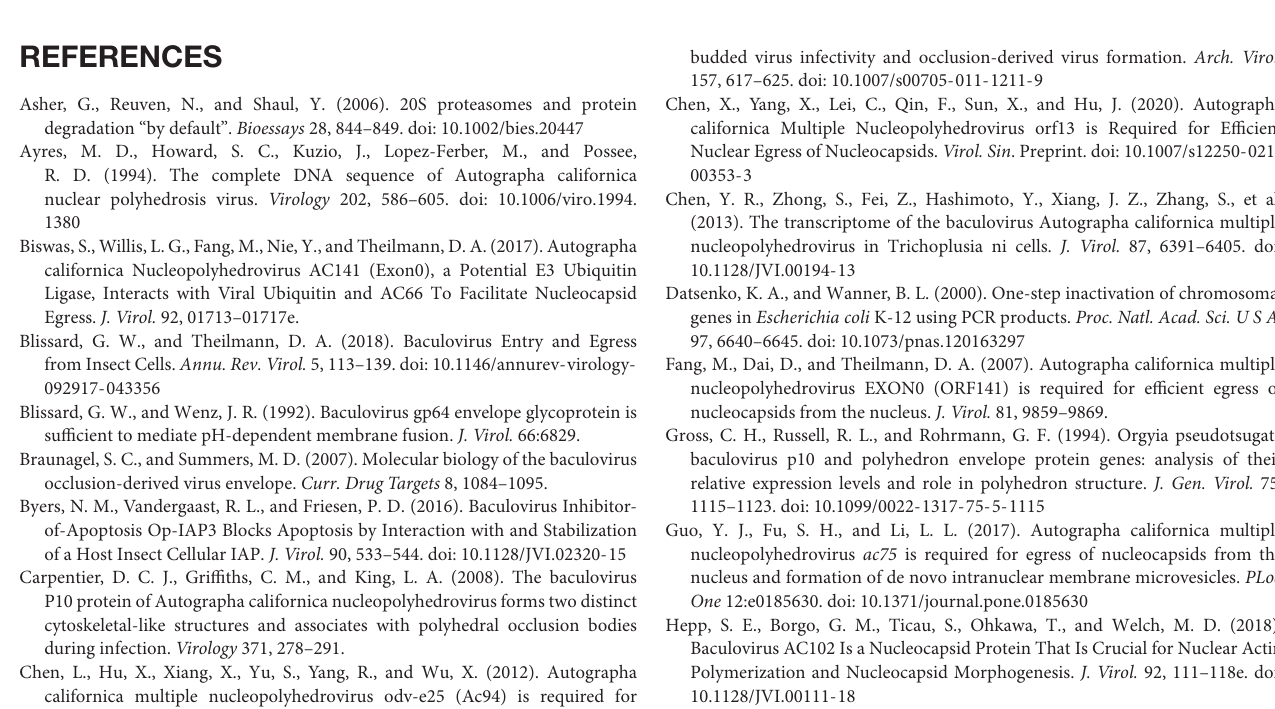
Supplementary Figure 2 | Immunoelectron microscopy analysis. Sf9 cells were infected with vAc- ph , vAc ac 75 F 54 S - ph, or vAc ac 75REP - ph at an MOI of five and harvested at 48 h p.i. Ultrathin sections were probed with the anti-AC75 antibody as the primary antibody and goat anti-rabbit IgG coated with gold particles